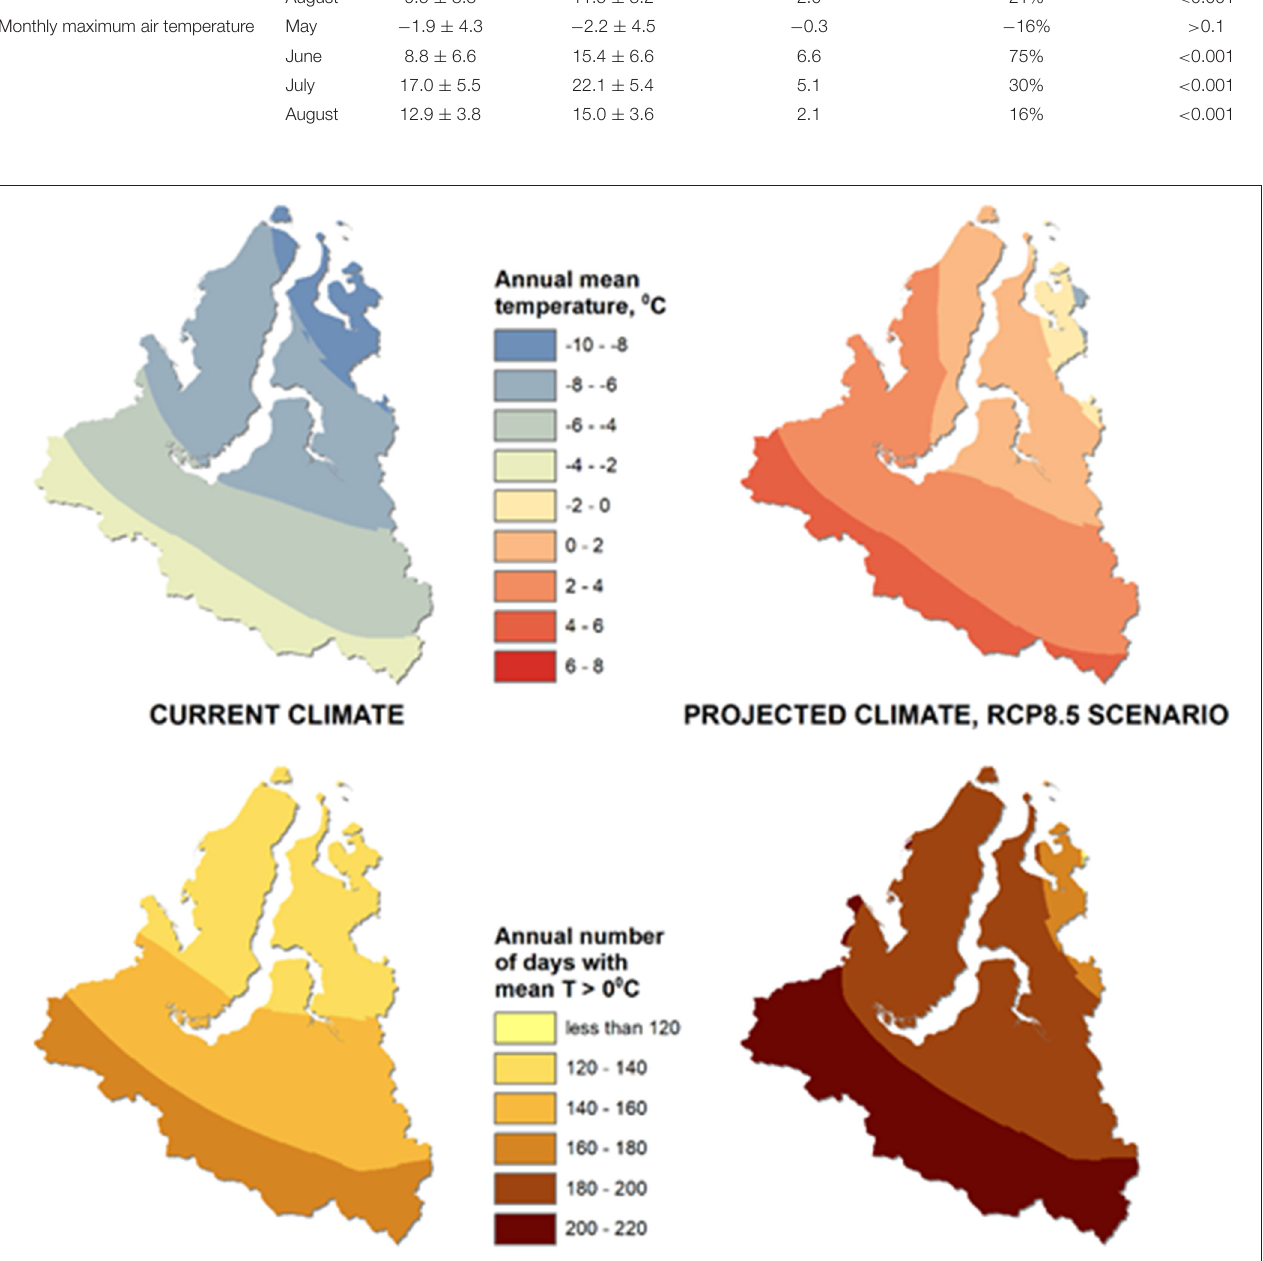
FIGURE 2 | Results of modeling the average annual air temperature (top) and the number of days per year with an air temperature above 0 ◦ C (bottom) on the territory of the Yamal-Nenets Autonomous Okrug for the current climate and for the projected climate (2081–2100) according to the RCP8.5 scenario.